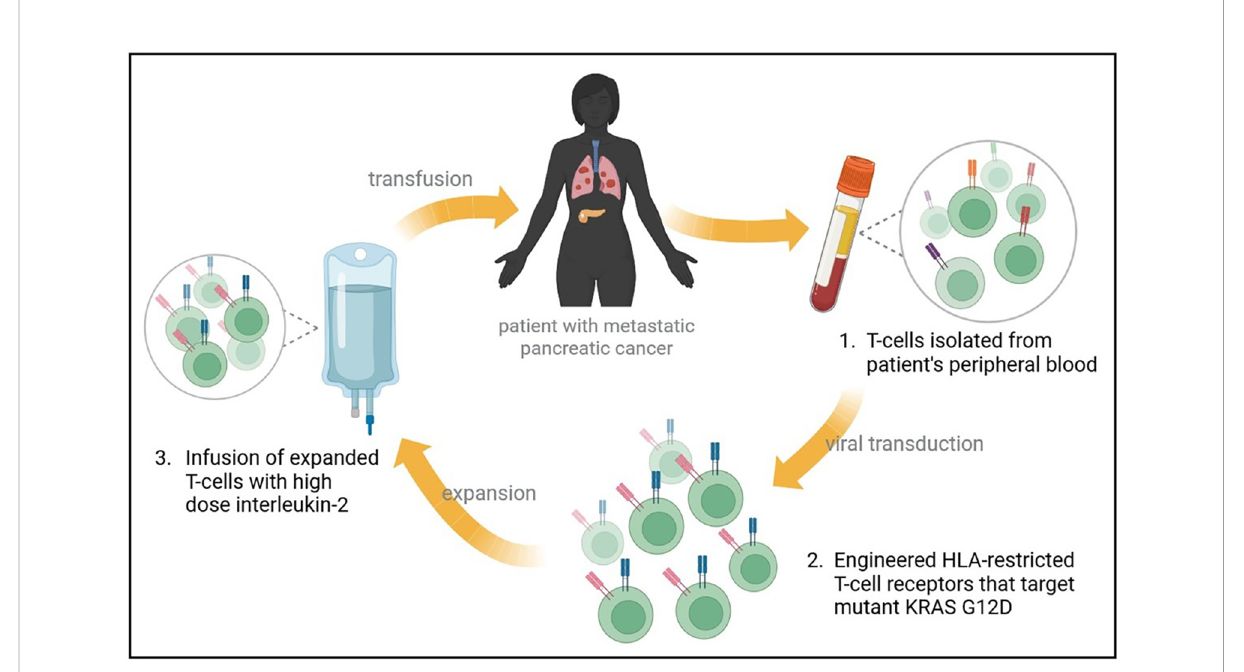
FIGURE 2 Treatment of metastatic PDAC with mutant KRAS-targeting genetically engineered T-cells. A heavily pretreated patient with metastatic PDAC to the lungs underwent an expiremental immunotherapy that targets mutant KRAS. Autologous T-cells were isolated and transfected with genes encoding two HLA-restricted T-cell receptors targeting KRAS G12D epitopes. The infusion product contained 16.2x10 9 T cells, and supportive high dose interleukin-2 therapy was administered. Metastatic lung lesions regressed at 1 month follow up, with continued regression at 6- months and an overall partial response rate of